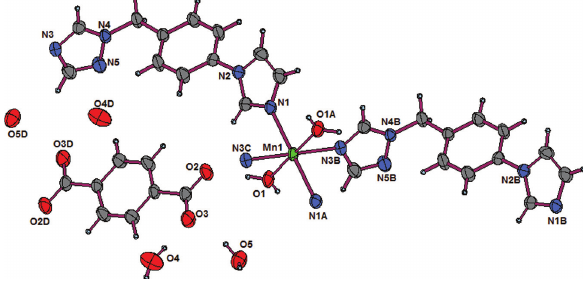
Table 1: Data collection and